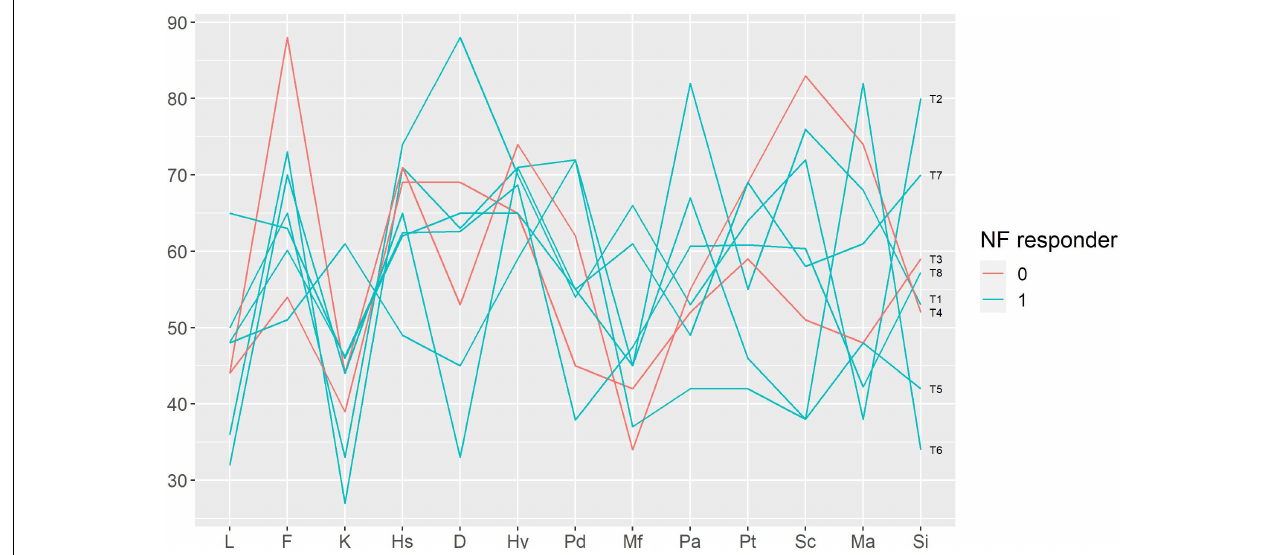
FIGURE 5 | Baseline Minnesota Multiphasic Personality Inventory profiles in participants with and without response to neurofeedback. Each line represents a patient case (indicated on the right end of the line). Neurofeedback responders are show in blue, neurofeedback non-responders — in red color. Minnesota Multiphasic Personality Inventory (MMPI) scales: L, F, K — validity scales, Hs — hypochondriasis, D — depression, Hy — hysteria, Pd — psychopathic deviate, Mf — masculinity-femininity, Pa — paranoia, Pt — psychasthenia, Sc — schizophrenia, Ma — mania, Si — social introversion; NF —